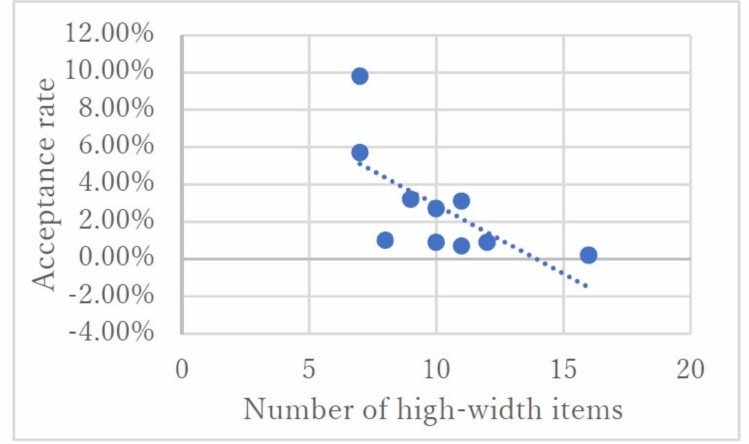
Figure 3. Distribution of the acceptance rates obtained using QBsolv at each instance and the numbers of high-width items at those instances.